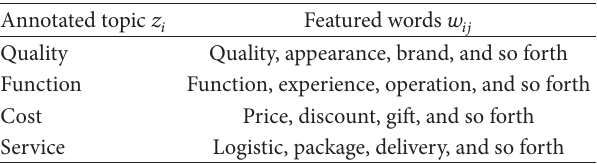
Table 5: Annotated